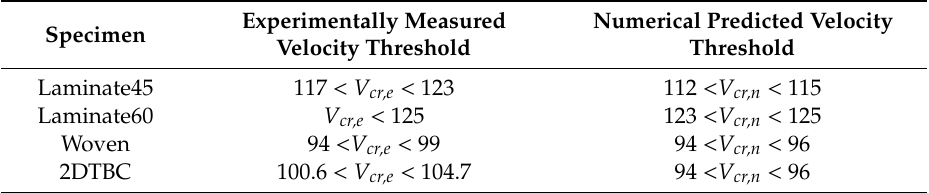
Table4. Comparisonofexperimentalmeasured( V cr,e )andnumericalpredicted( V cr,n )criticalpenetration Table 4. Comparison of experimental measured ( V cr,e ) and numerical predicted ( V cr,n ) critical velocities (m / penetration velocities (m/s).